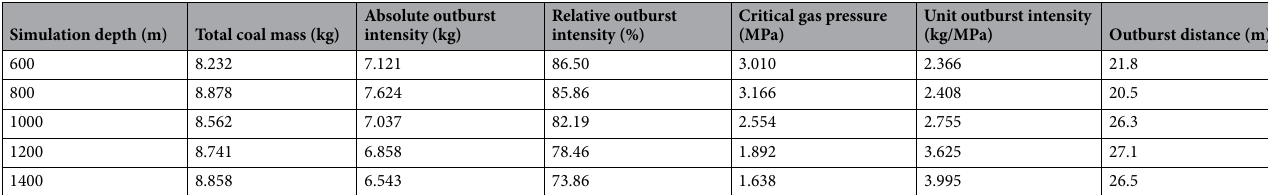
Table 2. Experimental results of coal and gas outburst under different simulation depths.